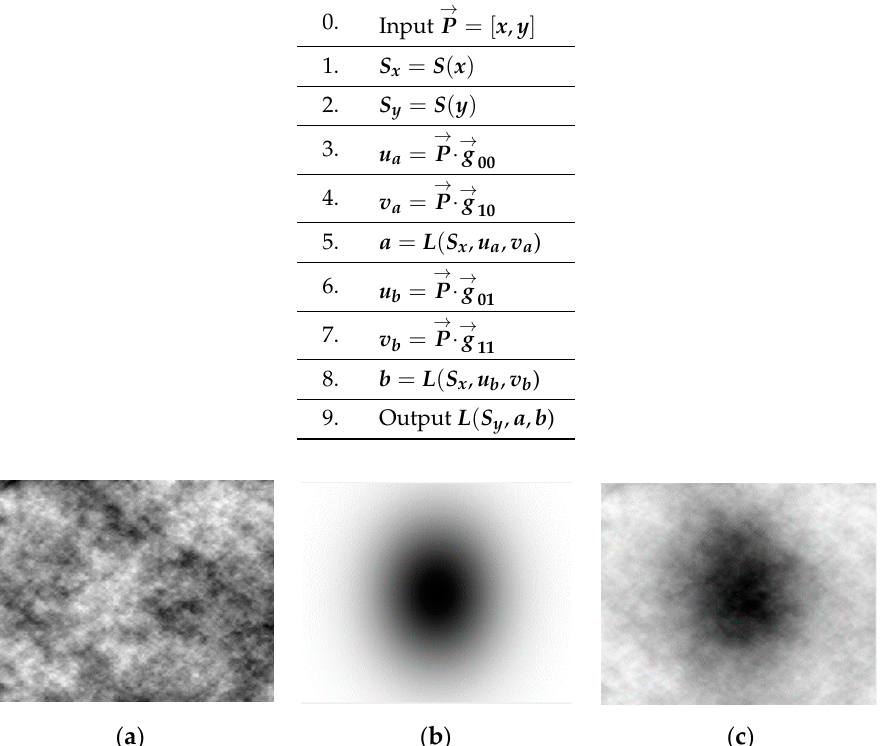
Figure 4. Generation of an SQ image ( a ) is added to a Gaussian image: PI; ( b ): GI; ( c ): a random Perlin noise image.